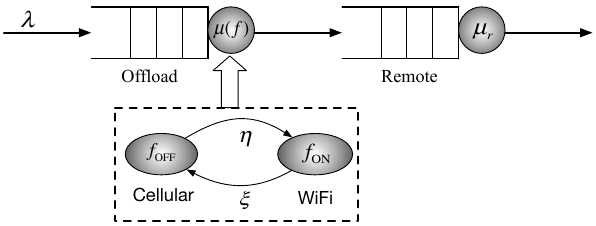
Figure 4: Non-delayed offloading model with cellular and WiFi